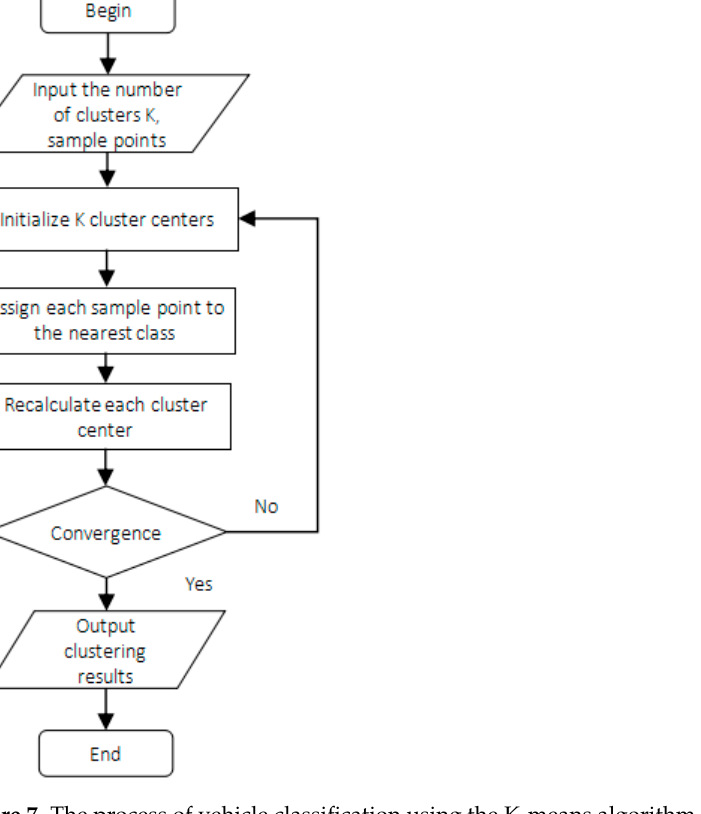
Figure 7. The process of vehicle classification using the K-means algorithm.